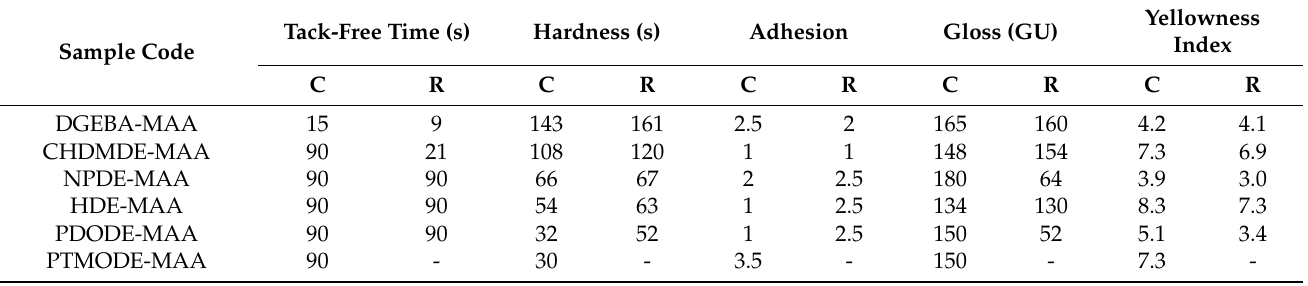
Table 4. Properties of the cured coatings prepared with obtained epoxy methacrylates depend on the photopolymerization mechanism (C—cationic,